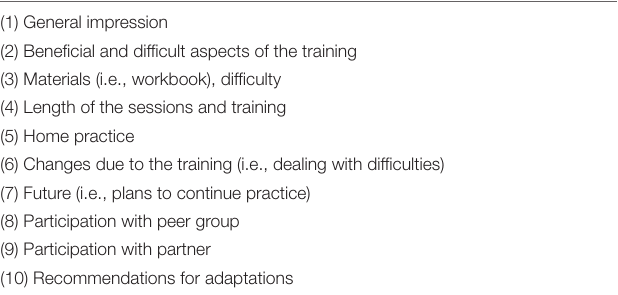
TABLE 1 | Topic list of semi-structured